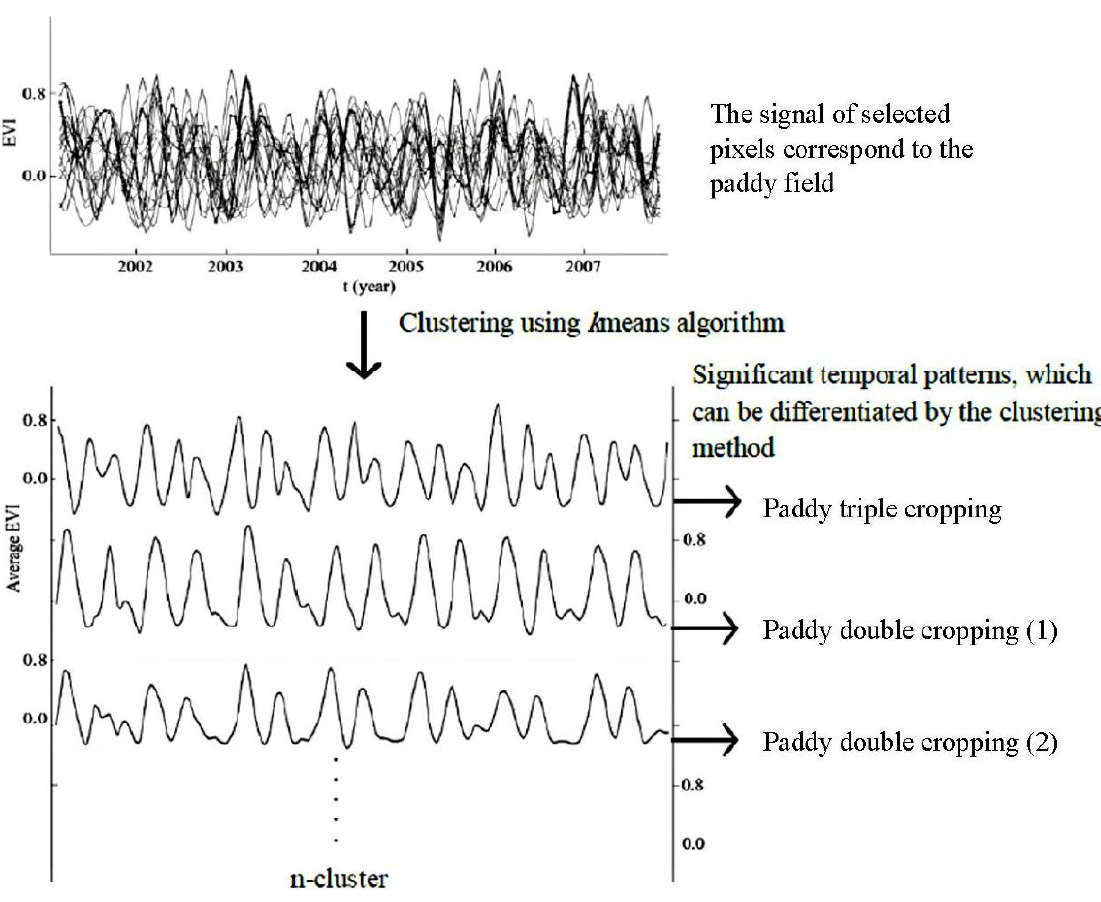
Figure 3. Clustering temporal patterns to distinguish cropping intensity in paddy